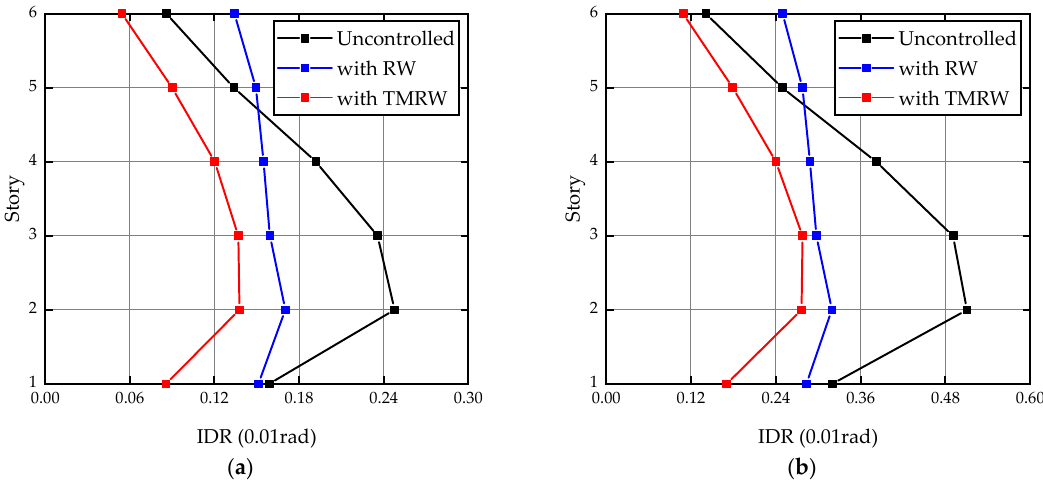
Figure 9. Comparison of the IDRs under El Centro earthquake excitation: ( a ) 0.1 g case; ( b ) 0.2 g case.